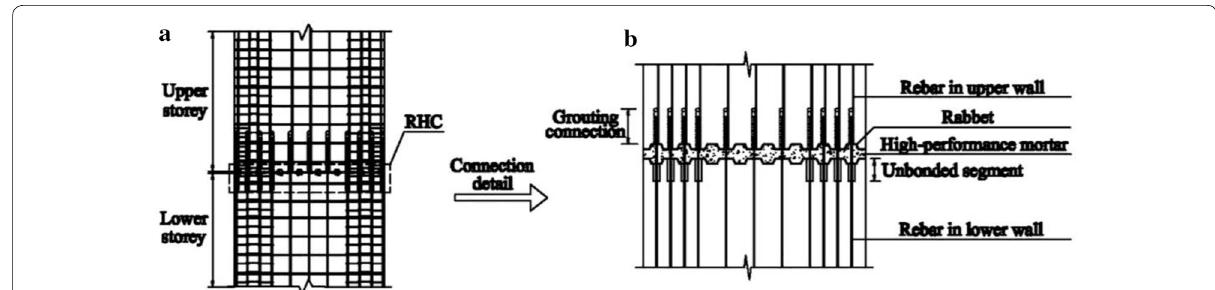
Fig. 1 a Precast shear wall and b the RHC details. For clarity, the horizontal distribution rebars in the upper and lower walls are not shown in Fig. 1 b .